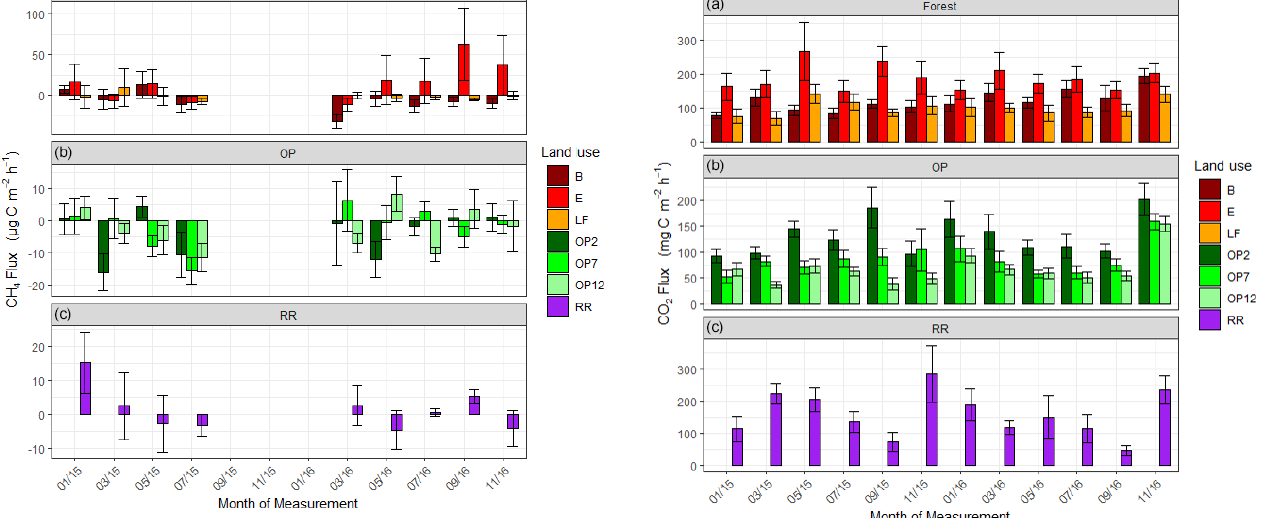
Figure 6. Soil respiration (CO 2 -C) rates in mgm − 2 h − 1 from Jan- uary 2015–November 2016, every 2 months ( a B, E, LF: logged forests; b OP2, OP7, OP12: oil palm plantations; c RR: riparian reserve). Bars are the mean for each site, and error bars are the stan- dard deviation of number of chambers per site. Please note the dif- ferent y -axis scale for